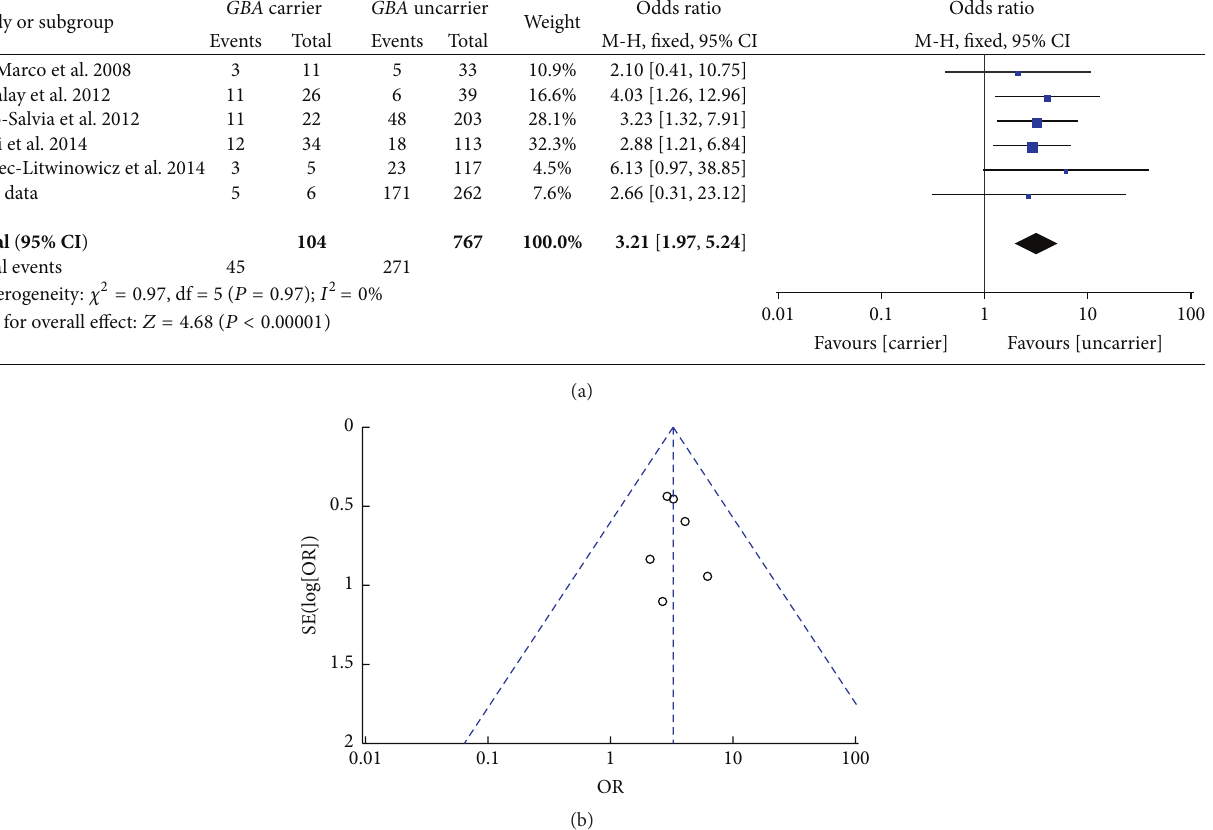
Figure 6: (a) Forest plot of dementia in GBA + PD and GBA − PD. (b) Funnel plot of dementia in GBA + PD and GBA −